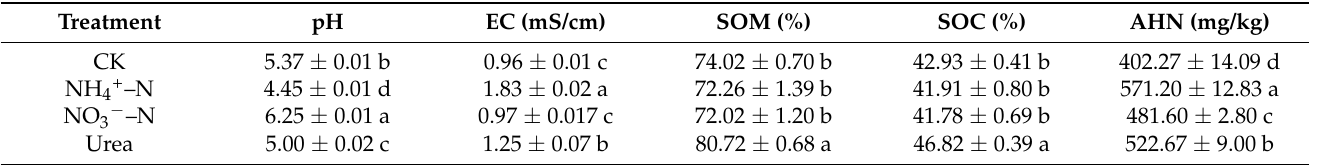
Table 2. Physical and chemical properties of the cultivation substrate with different N